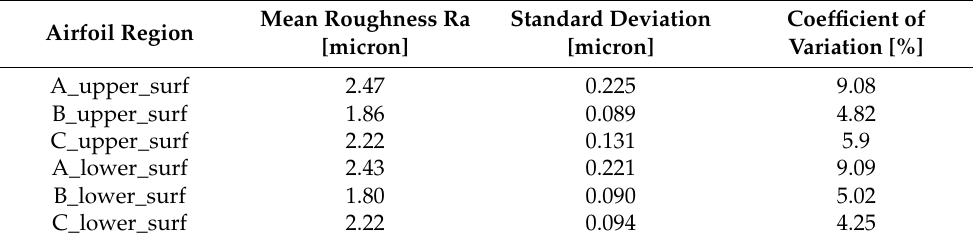
Table 5. Statistics of wing surface roughness Ra for five samples.